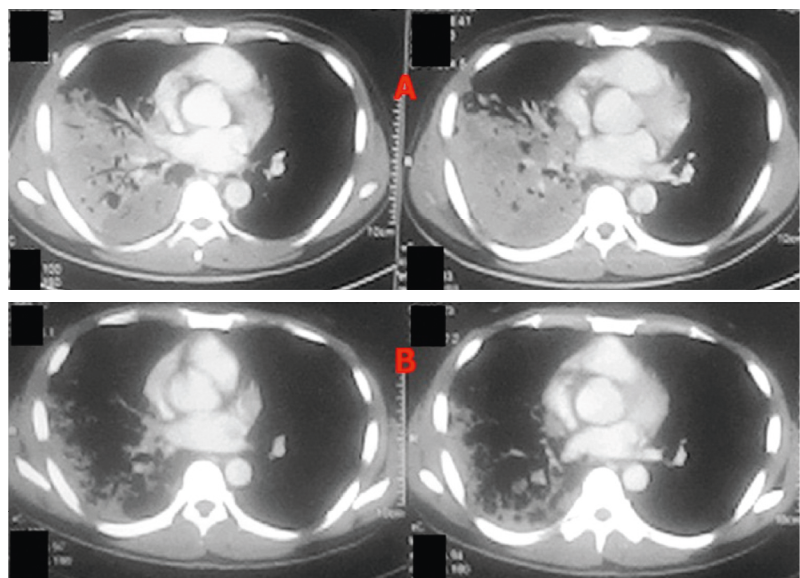
Figure 1: Two chest CTscans were undertaken 14 days apart. (a) The first chest CTshowing consolidation at the right lower lobe with small cavities. (b) The second chest CT with significant amelioration of consolidation at the same